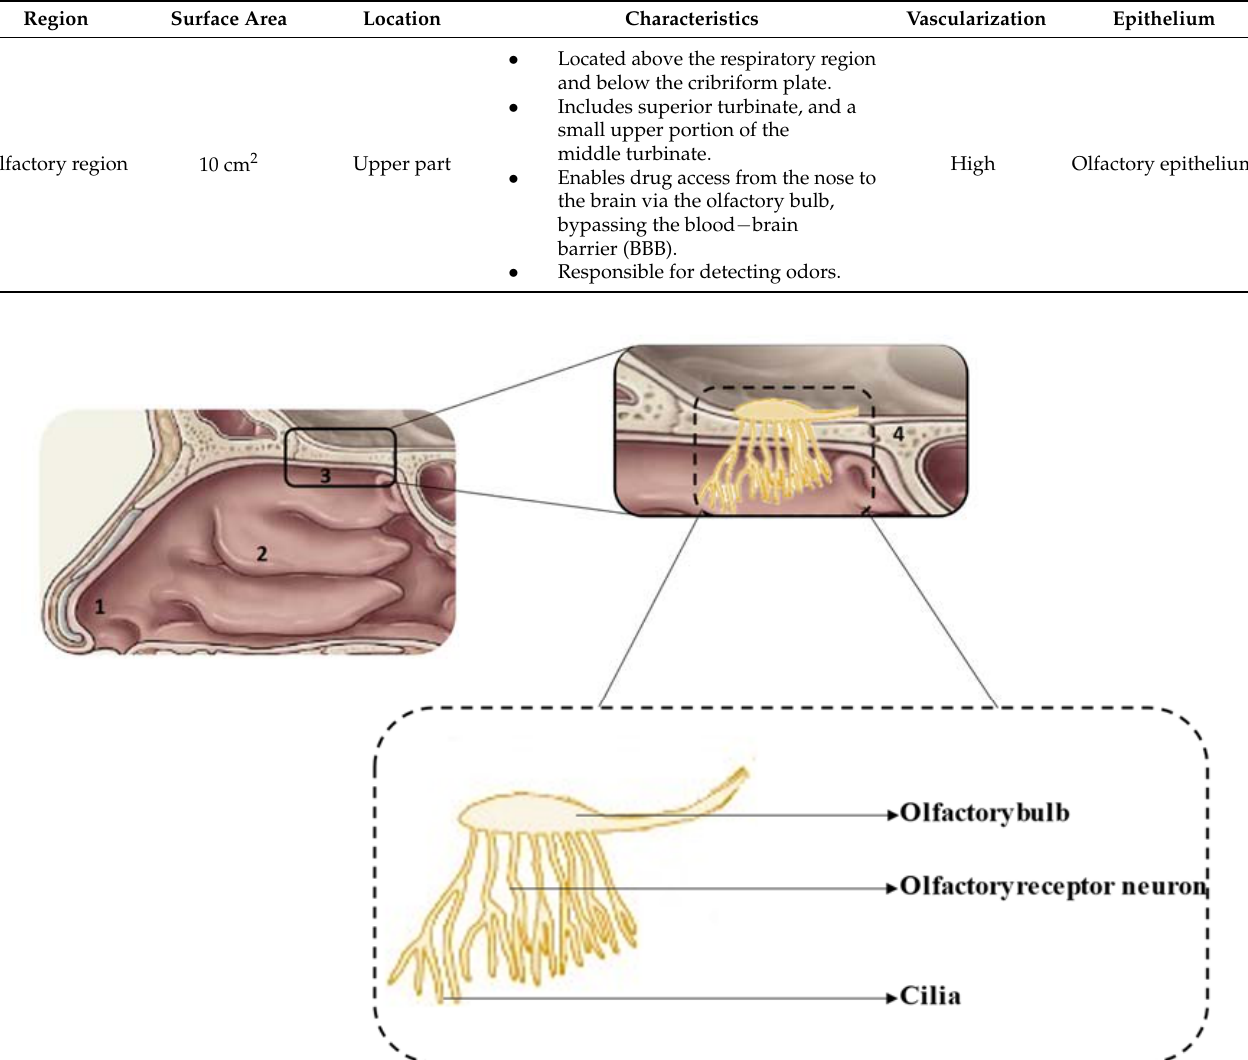
Figure 1. Schematic representation of the nasal cavity ( top ) and olfactory region ( bottom ): 1—vestibule, 2—respiratory region, 3—olfactory region, 4—cribriform plate.